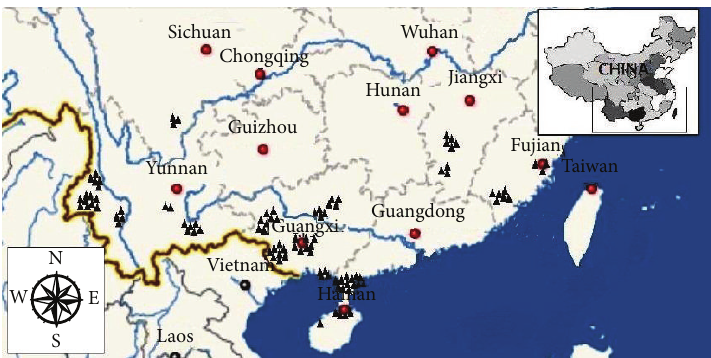
Figure 1: Geographic locations of the 100 S. scitamineum isolates isolated from 7 Provinces of China. Notes: The seven provinces where the S. scitamineum isolates were collected are marked in the red dots.